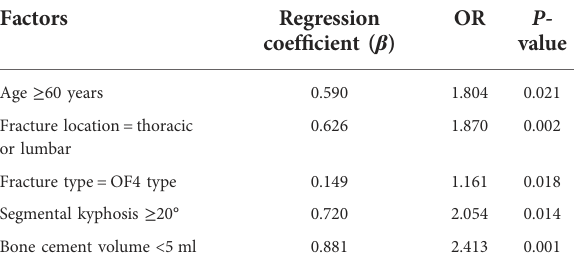
TABLE 2 Multivariate logistic regression analysis of the risk factors of residual back pain after PKP.